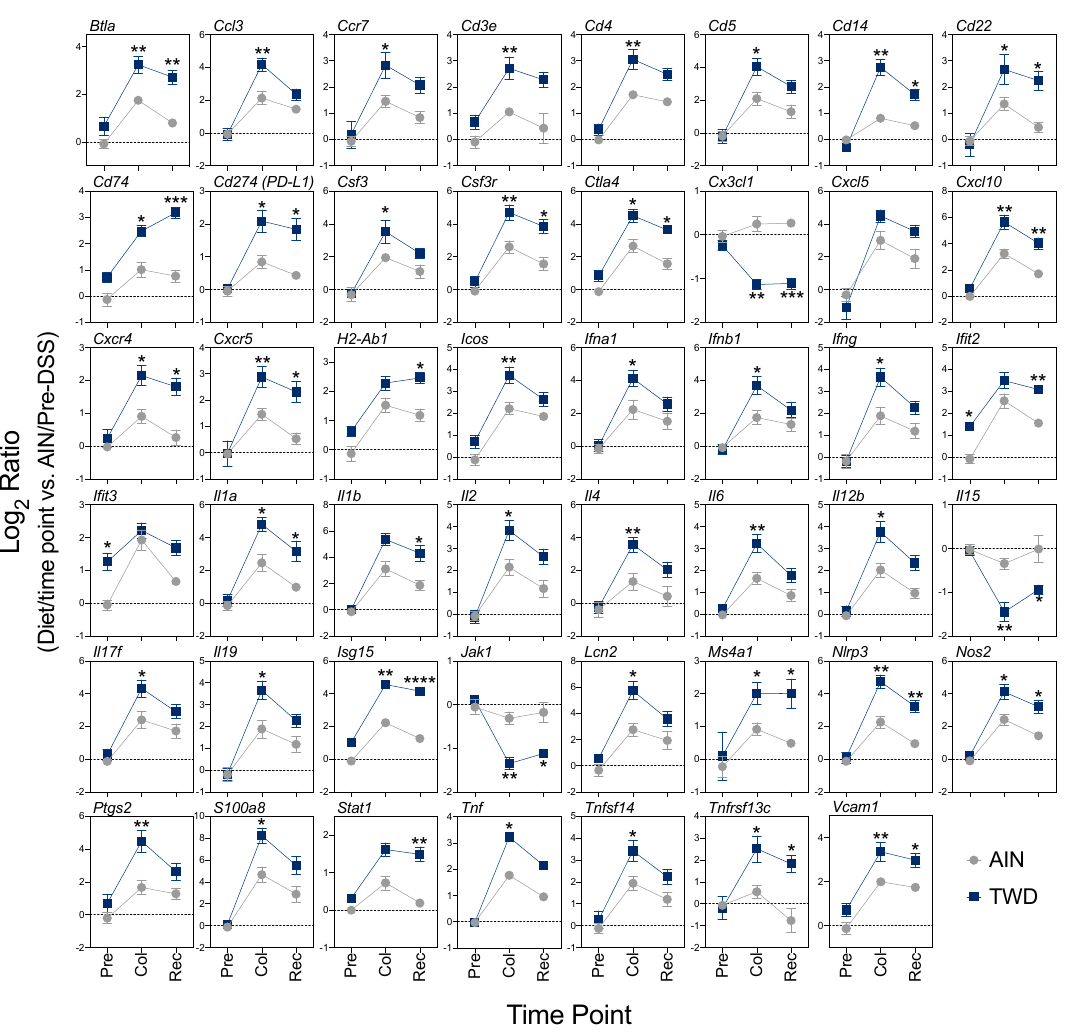
Figure 10. Expression profiles for selected genes of interest associated with immune and inflammatory responses. Values shown are the average log 2 ratio ± SEM for selected genes calculated with AIN / Pre-DSS as the reference. Significant di ff erences in expression (FDR-corrected q -value < 0.05 and log 2 ratio > 1 or < − 1) between TWD and AIN diets at each time point are noted as follows: * q < 0.05; ** p < 0.01; *** p < 0.001; **** p < 0.0001. Statistical results for comparisons across time points within each diet group are not shown here, but are available in File S2 along with the specific FDR q -values for the significant observations noted in the figure. Pre, pre-DSS; Col, colitis; Rec; recovery.